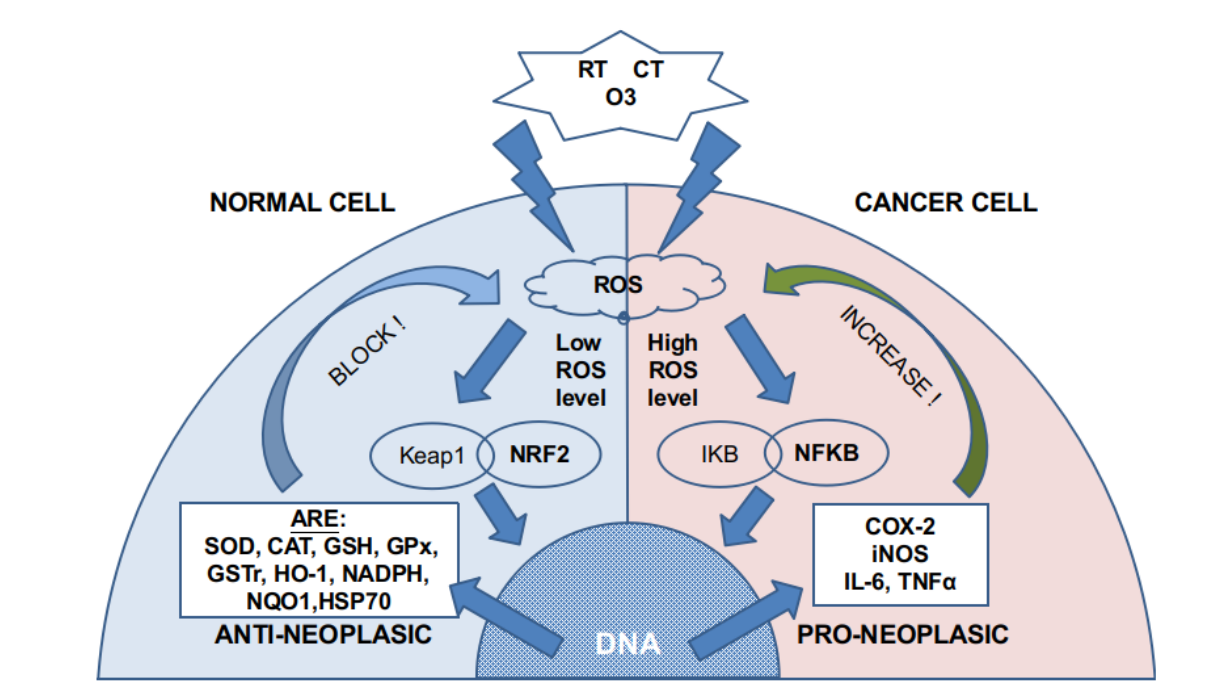
Figure 1. ROS generation by RT, CT, and ozone. According to previous cytoplasmic and mitochondrial ROS levels, different pathways are activated. Normal cells have a low ROS level, whereas cancer cells have high or very high ROS levels. The NRF2 pathway is almost exhausted in cancer cells, so more ROS activate the NFKB pathway.